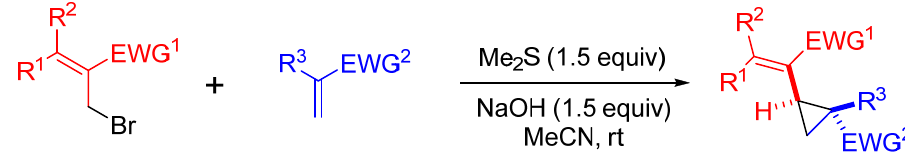
Table 13. Scope of Kim’s diastereoselective cyclopropane synthesis (Scheme 41).